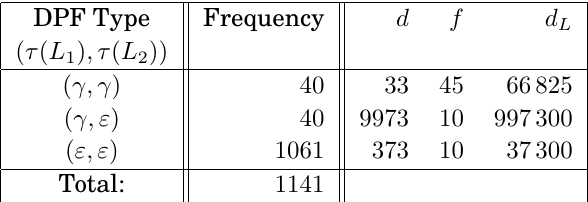
Table 19: Types of doublets with two non-split prime divisors of regular f .